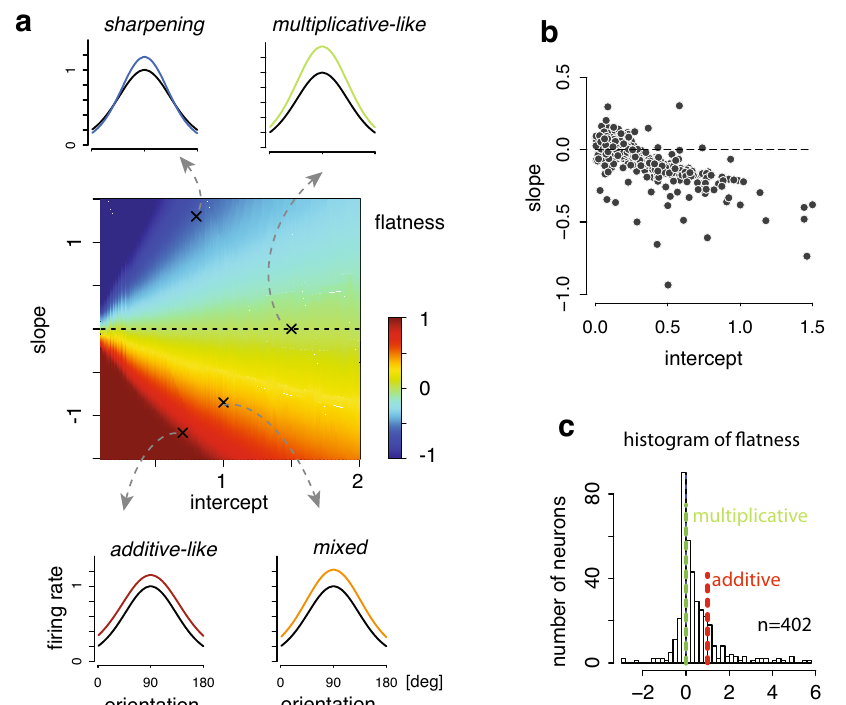
Fig. 4 | Power-law modulation accounts for both additive and multiplicative modulations. a The “ fl atness ” index as a function of the slope and intercept parameters of the power-law relation. The “ fl atness ” index quanti fi es the extent to whichthe fi ringratechangedependsonthestimulusorientation.Itmanifestsitself as multiplicative and additive modulations, among others, in certain parameter regimes. Multiplicative gain would lead to a zero “ fl atness ” index, while additive